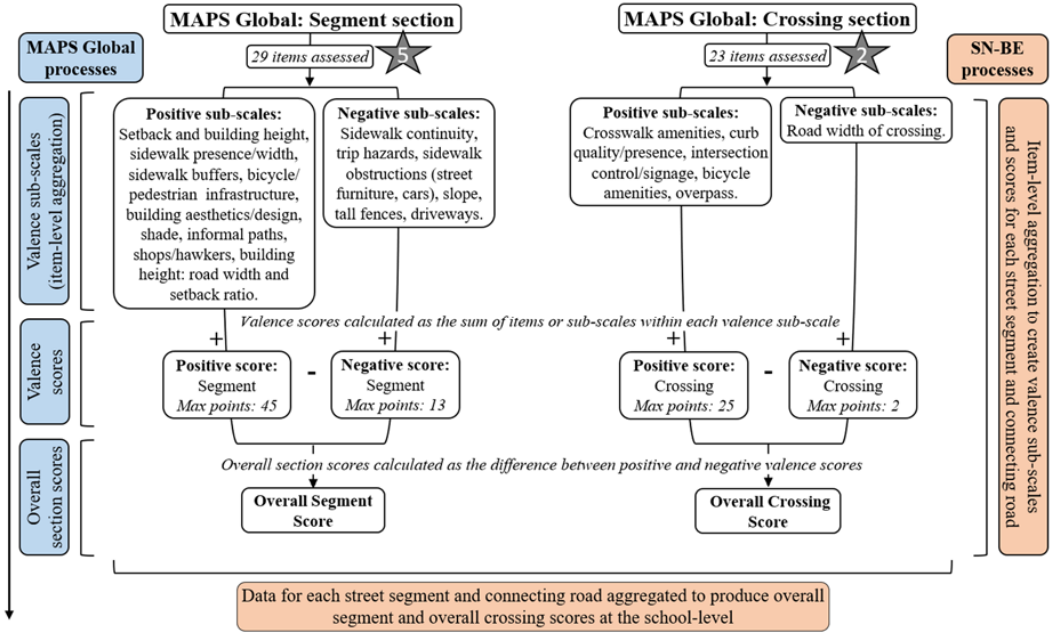
Figure 3. Hierarchical scoring system of MAPS Global segment and crossing sections (adapted from [43]). Note. Star denotes number of item-level modifications. Max points refers to the maximum number of points available from the summation of sub ‐ scales.